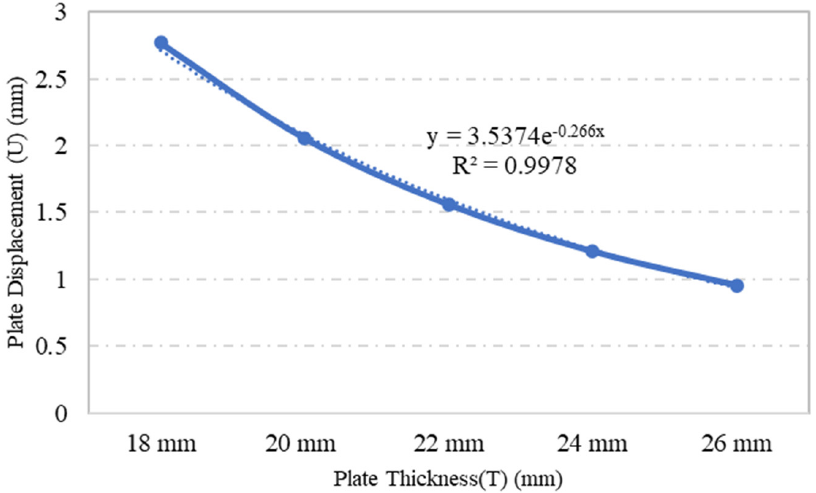
Figure 9. Influence of plate thickness on plate maximum displacement.